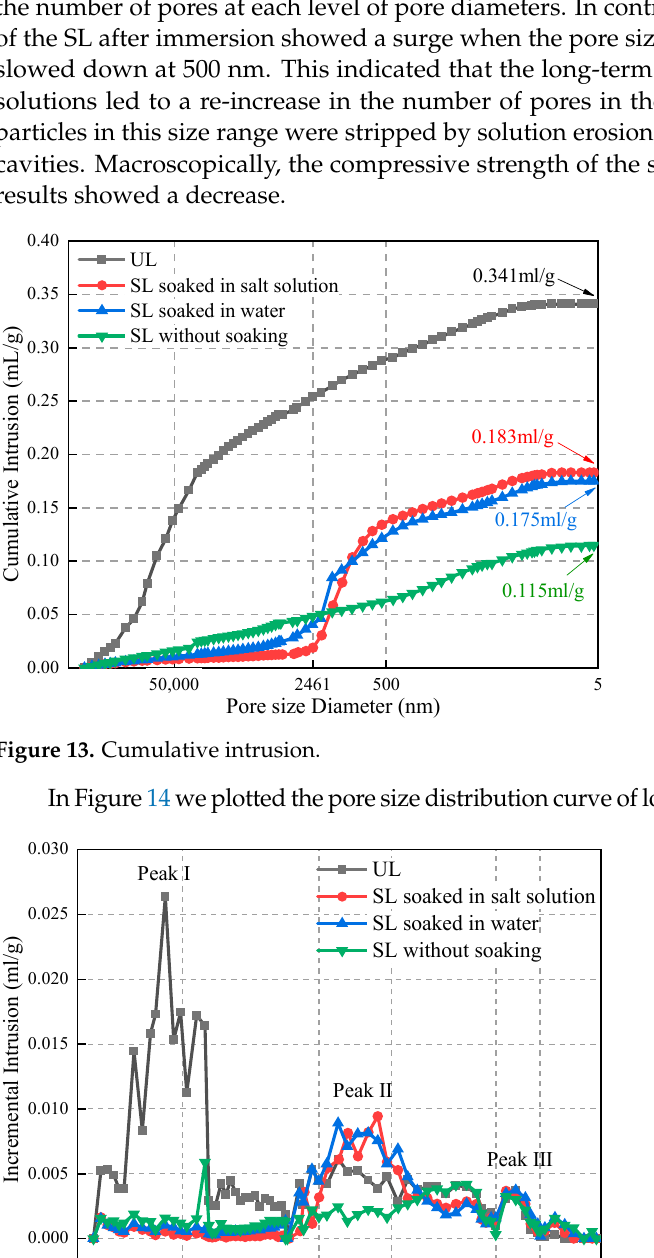
Figure 12. The SEM of UL and SL in different service environments. ( a ) UL, ( b ) SL without soaking, ( c ) SL soaked in water, ( d ) SL soaked in salt solution.